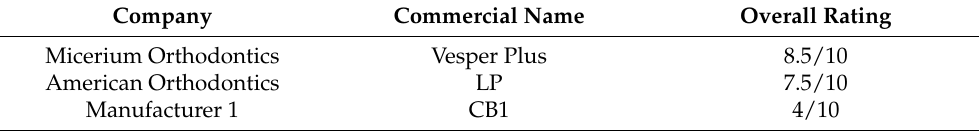
Table 11. Conventional brackets overall rating.